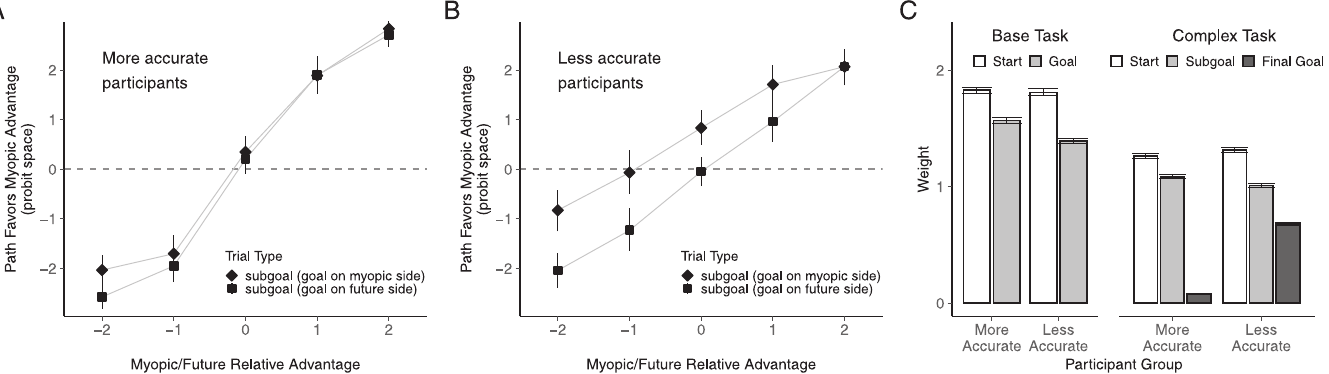
Fig 7. Individual differences in weighting subgoal-relevant factors and the subgoal-irrelevant final goal. A. and B. Subgoal trial path choices associated with the two accuracy groups. As in Fig 6A, the proportion of optimal trials for each individual was converted into a probit score, with individual probit scores larger than 3 or smaller than -3 capped at 3 or -3 before averaging. C. Drift weight estimates in both task conditions for the two accuracy groups.